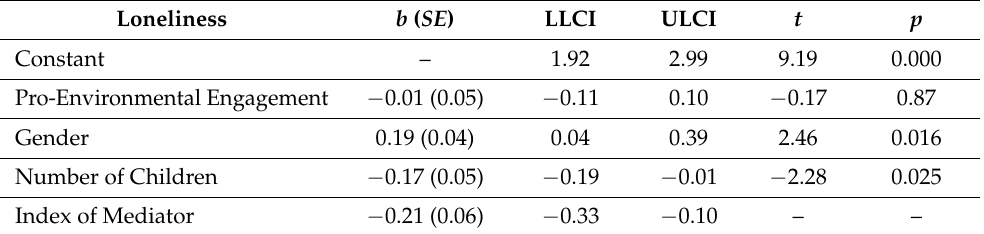
Table 2. Model parameters for mediation analysis on loneliness. Loneliness b ( SE ) LLCI ULCI t p Constant – 1.92 Pro-Environmental